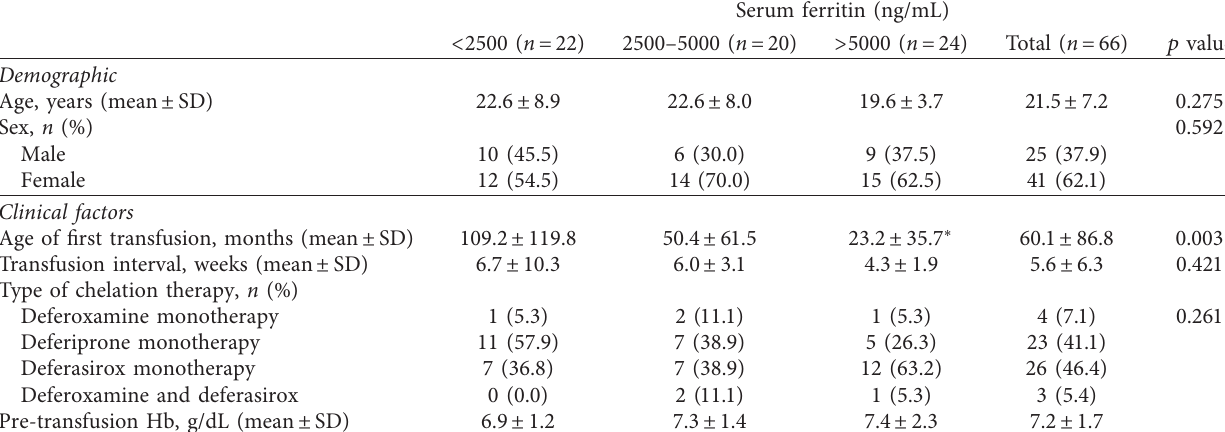
Table 1: Patient baseline characteristics for the total sample and stratified by serum ferritin level classification.